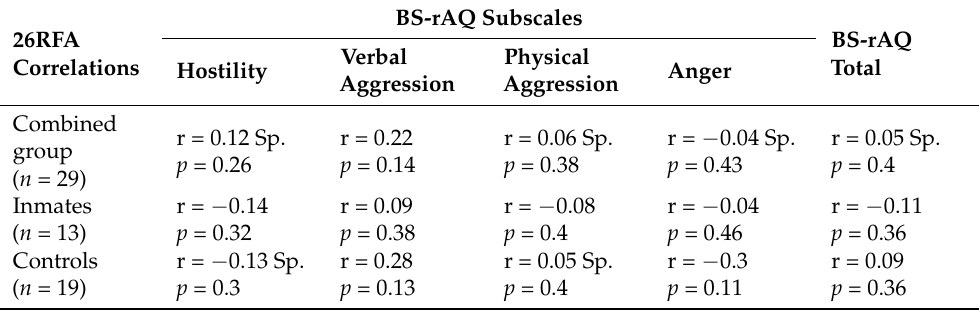
Table 3. Correlations between BS-rAQ total and subscale scores with plasma concentrations of 26RFa in the combined group of men which includes inmates who committed aggressive acts, as well as men from the general population as controls and in the two groups separately. In the combined group, 3 high levels 26RFa outliers of the inmate group have been removed. Correlation coefficients (Pearson’s or Spearman’s (Sp.) -r), with corresponding p -values, are